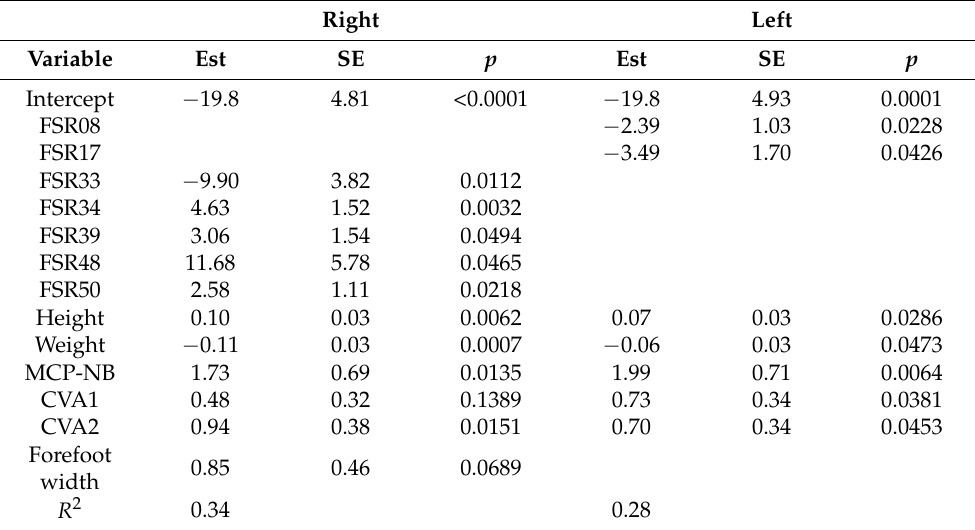
Table 4. Regression models based on plantar pressure for one height and personal features.